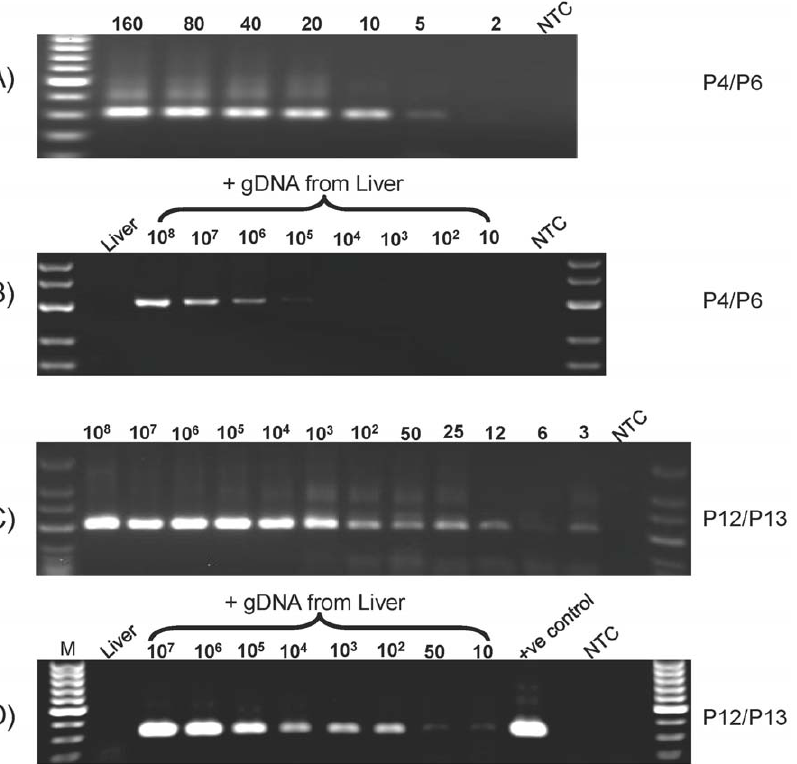
Figure 3. Effect of non-specific gDNA on the specificity and sensitivity of MSP. The unmethylated Ins2 gene plasmid was diluted in the presence or absence of 500 ng non-specific gDNA, bisulfite-treated, and used as template for PCR. A) 160, 80, 40, 20, 10, 5, and 2 copies of plasmid without non-specific DNA analyzed by qMSP using primer set P4/P6. B) Serial dilutions ranged from 10 8 to 10 copies of plasmid in the presence of non-specific gDNA analyzed by qMSP using primer set P4/P6. C) Serial dilution from 10 8 to 3 copies of plasmid in the absence of non-specific gDNA analyzed by qMSP using primer set P12/P13. D) Range of serial dilutions from 10 7 to 10 copies plasmid in the presence of non-specific gDNA analyzed by qMSP using primer set P12/P13. Mouse liver gDNA was used as non-specific DNA and NTC is the non-template